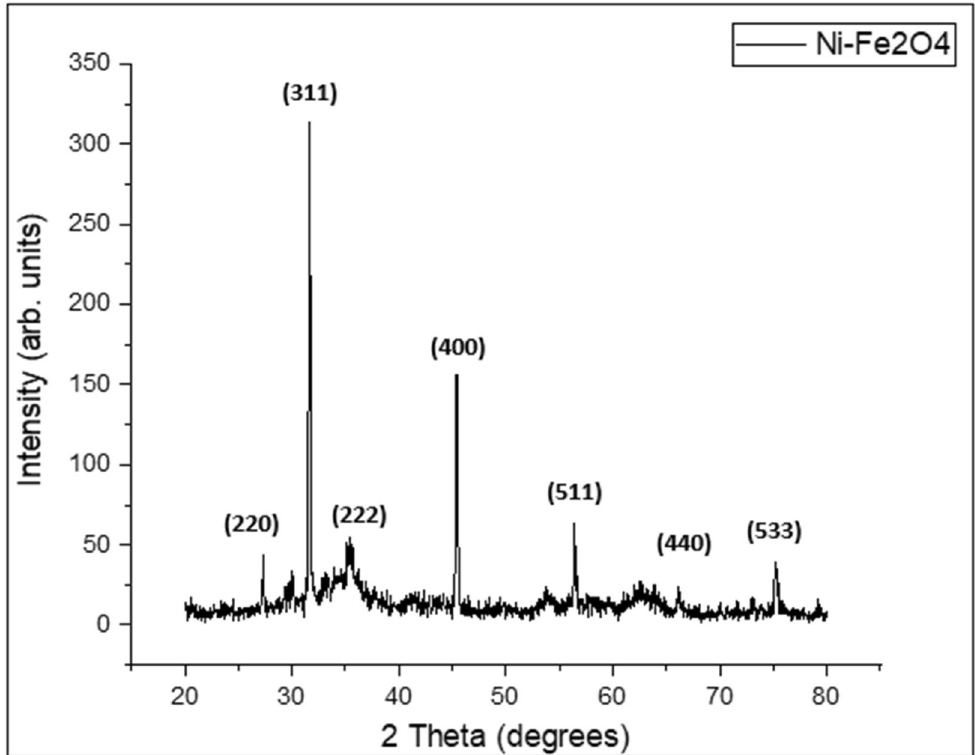
Figure 1. XRD pattern of synthesized nickel ferrite nanoparticles.